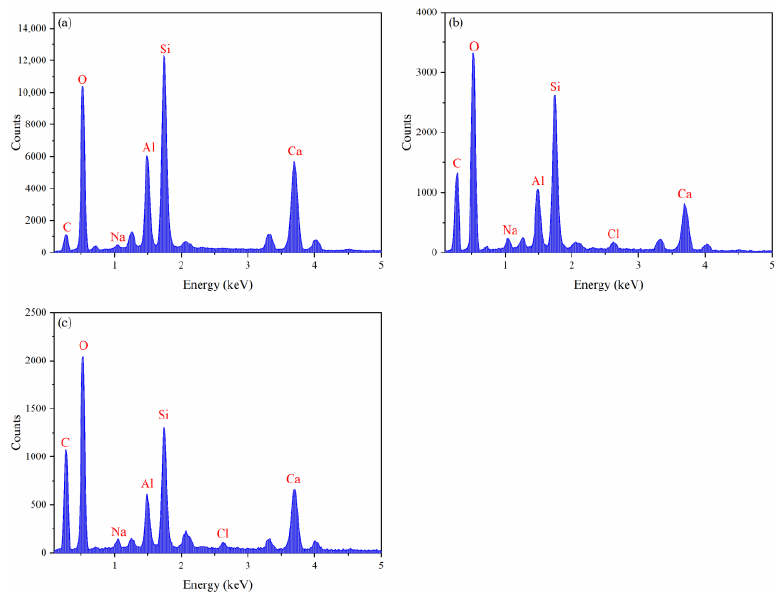
Figure 10. EDS elemental mapping of filter cakes of gel – sediment solutions: ( a ) sediments; ( b ) sediments + 0.5 wt% xanthan gum; ( c ) sediments + 0.5 wt% pectin.